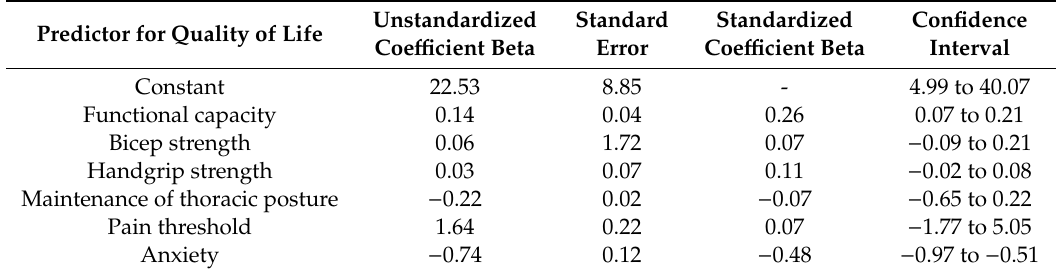
Table 2. Multiple regression model for quality of life in women with fibromyalgia. Predictor for Quality of